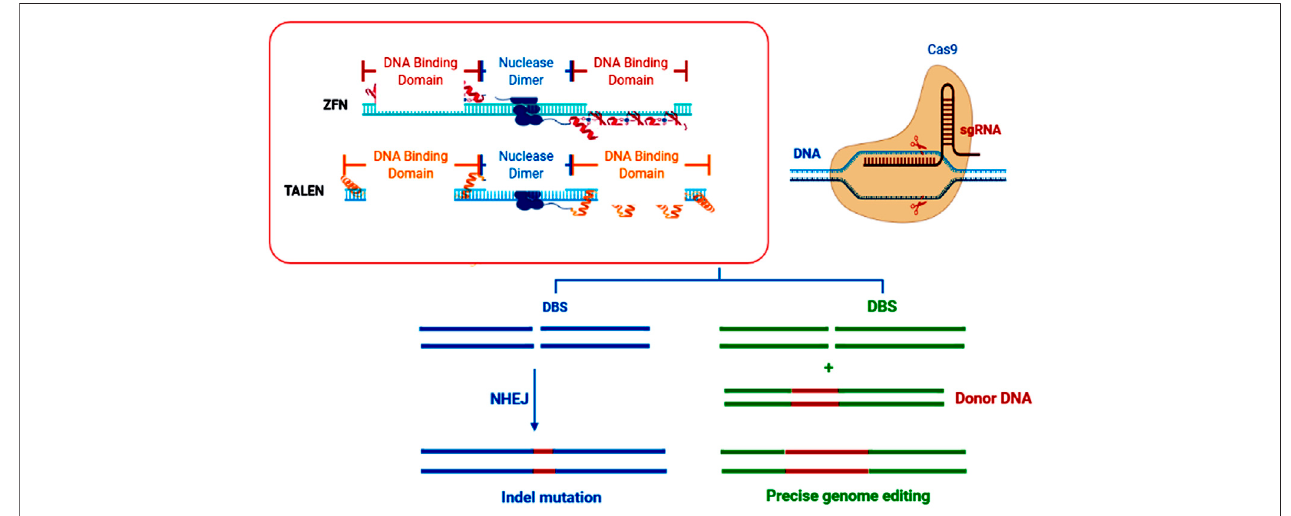
FIGURE 1 | Schematic diagram of the NHEJ and HDR DNA repair pathways when DNA double-strand breaks (DSBs) are produced by sequence-speci fi c nucleases (SSNs). CRISPR-based genome editing takes advantage of Cas9 ’ s ability to induce targeted DNA double-strand breaks (DSBs) usually a few nucleotides upstream of the PAM sequence. The chromosomal DSBs are repaired by the cell via two repair pathways, either non-homologous end joining (NHEJ) or homology- directed repair (HDR). At its core, NHEJ-break ends can be ligated without a homologous template, while HDR-breaks require a template to guide repair.